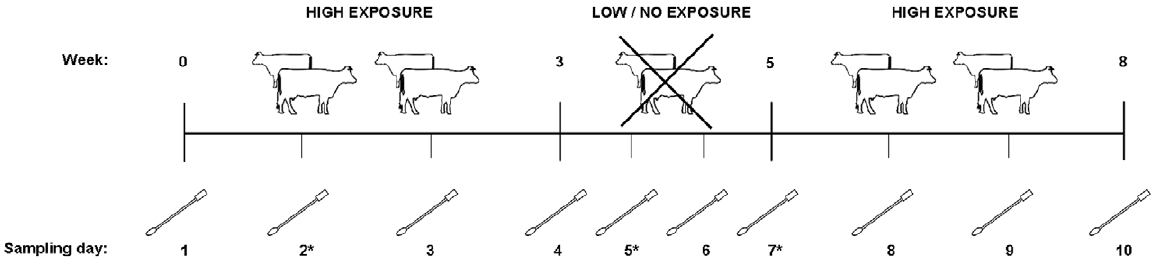
Figure 1. Schematic overview of the study design. Participants were followed for approximately two months during periods of both high and low/no exposure. The study starts 3 weeks prior to, and ends 3 weeks after, the low/no exposure period. Nasal and throat swabs were taken in the morning and evening once a week in high exposure periods, and twice a week in low exposure period. * Nasal samples taken in the evening of sampling day 2 (high exposed), 5 and 7 (low exposed) were additionally screened for MSSA.